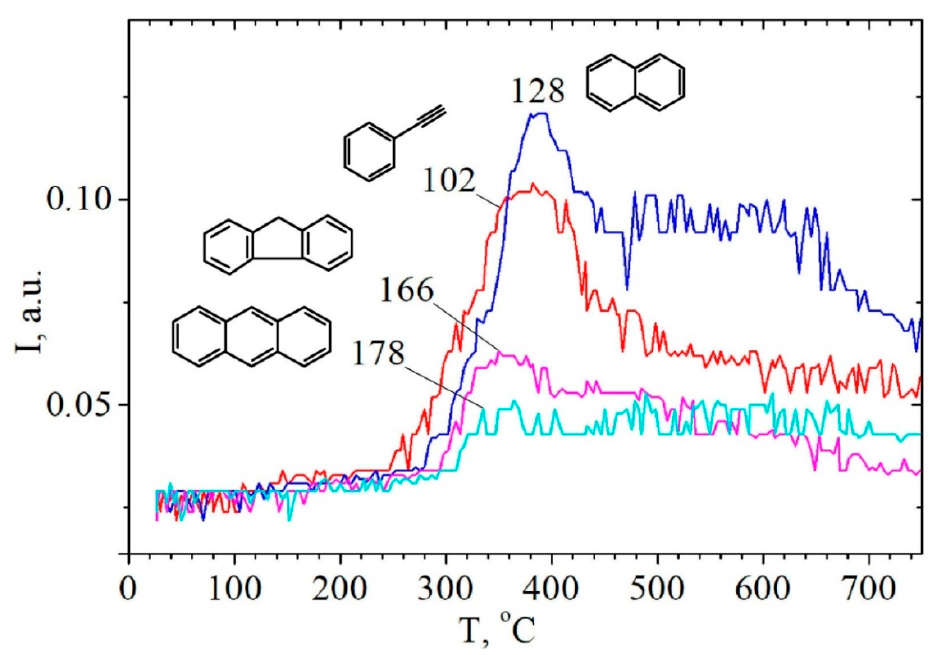
Figure 4. TPD-curves of the ions with m / z = 178, 166, 128, 102 obtained during pyrolysis of rice husk hydrolytic lignin.